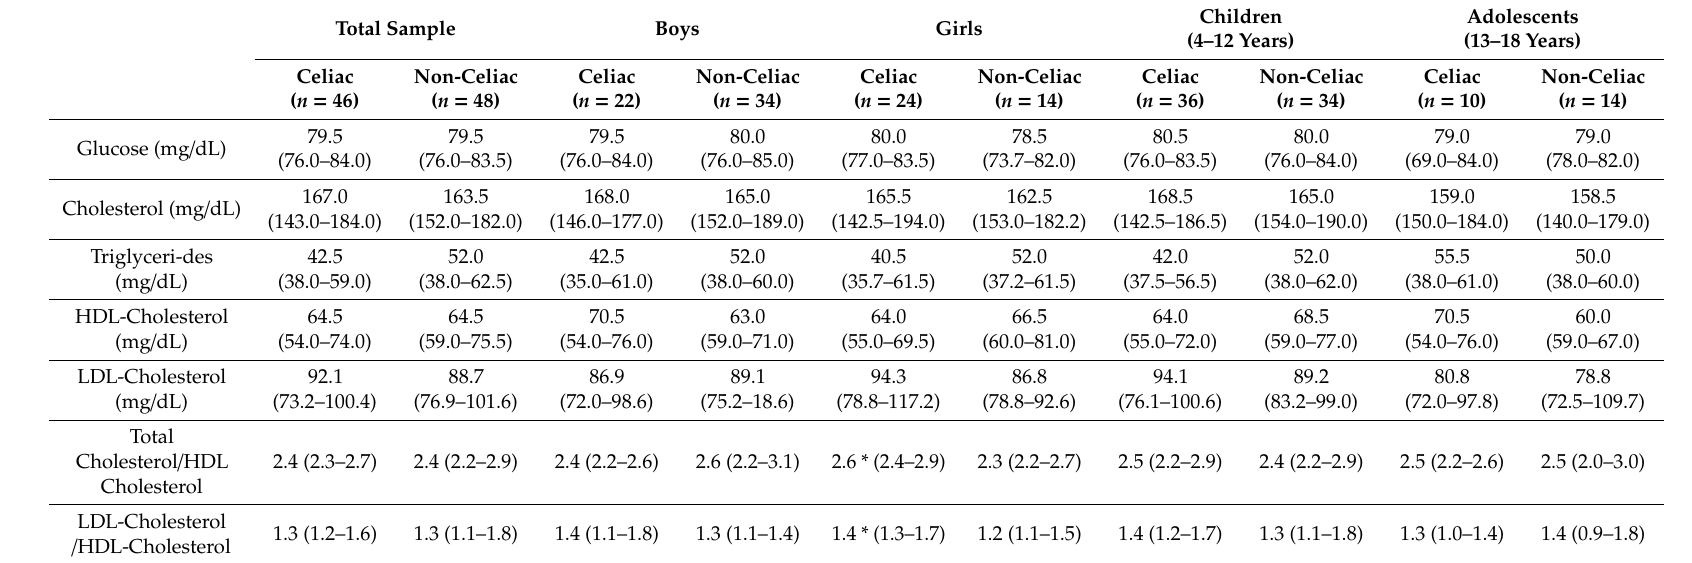
Table 11. Biochemical parameters in celiac and non-celiac children and adolescents.